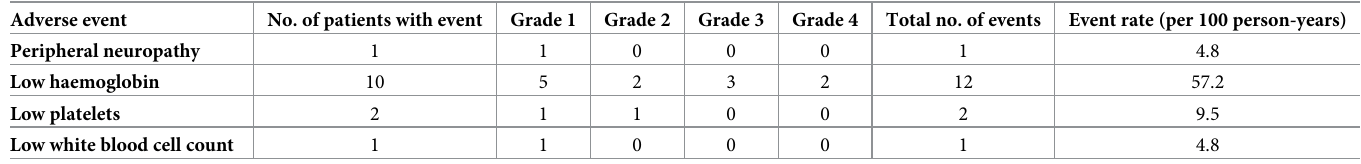
Table 5. Adverse events, possibly, probably or definitely attributed to linezolid, in children treated for MDR-TB with linezolid ( n = 17), by grade. Adverse event